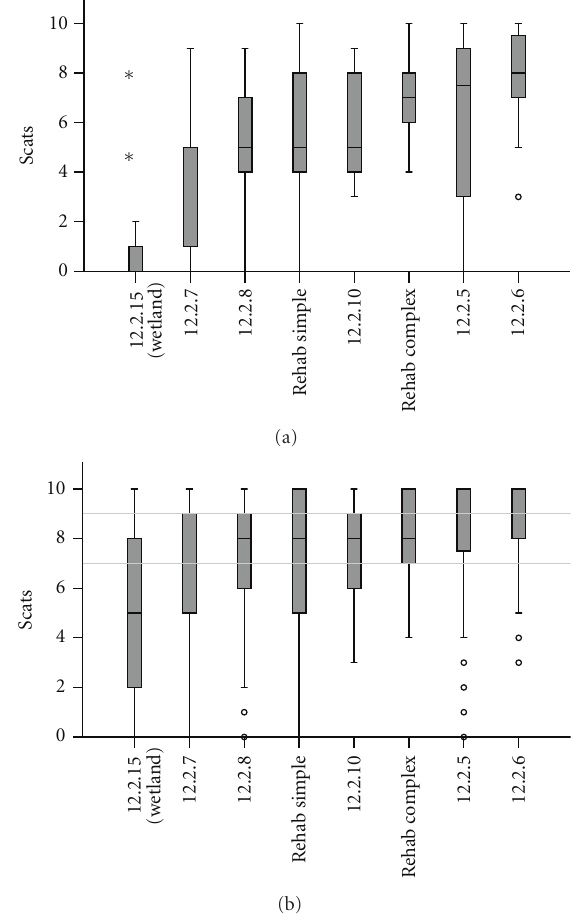
Figure 3: Boxplots (minimum, first quartile, median, third quar- tile, and maximum, with outliers ◦ and extreme values ∗ ) show-ing the variability of the average number of scats remaining by vege- tation community (a) after 36 weeks, (b) all 36 weeks combined (grey lines in (b) include max and min medians of all but wetlands). Boxplots are ordered from the vegetation community with the least remaining scats (12.2.15) to the one with most remaining scats (12.2.6). NB: vegetation communities (12.2.10: mallee